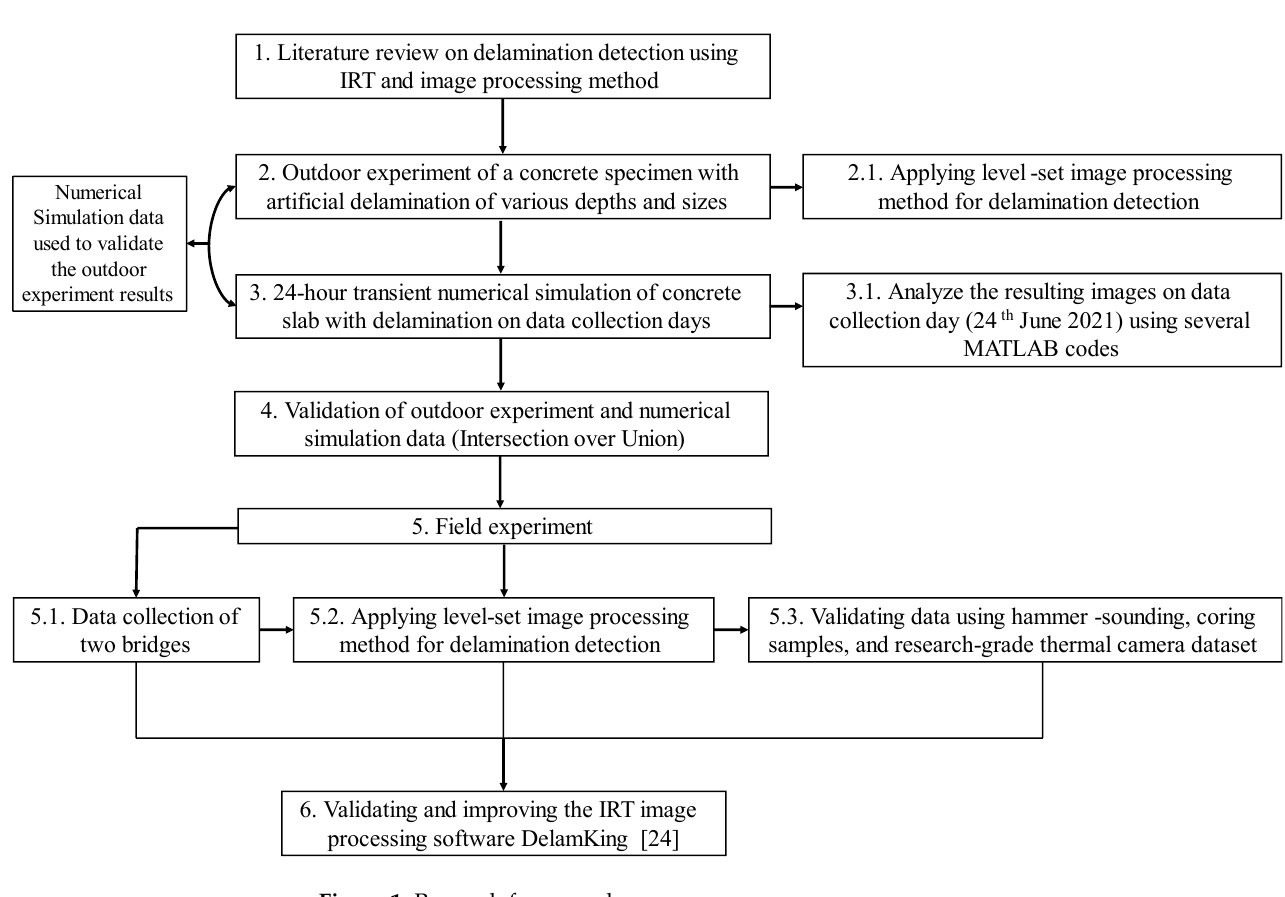
Figure 1. Research framework.